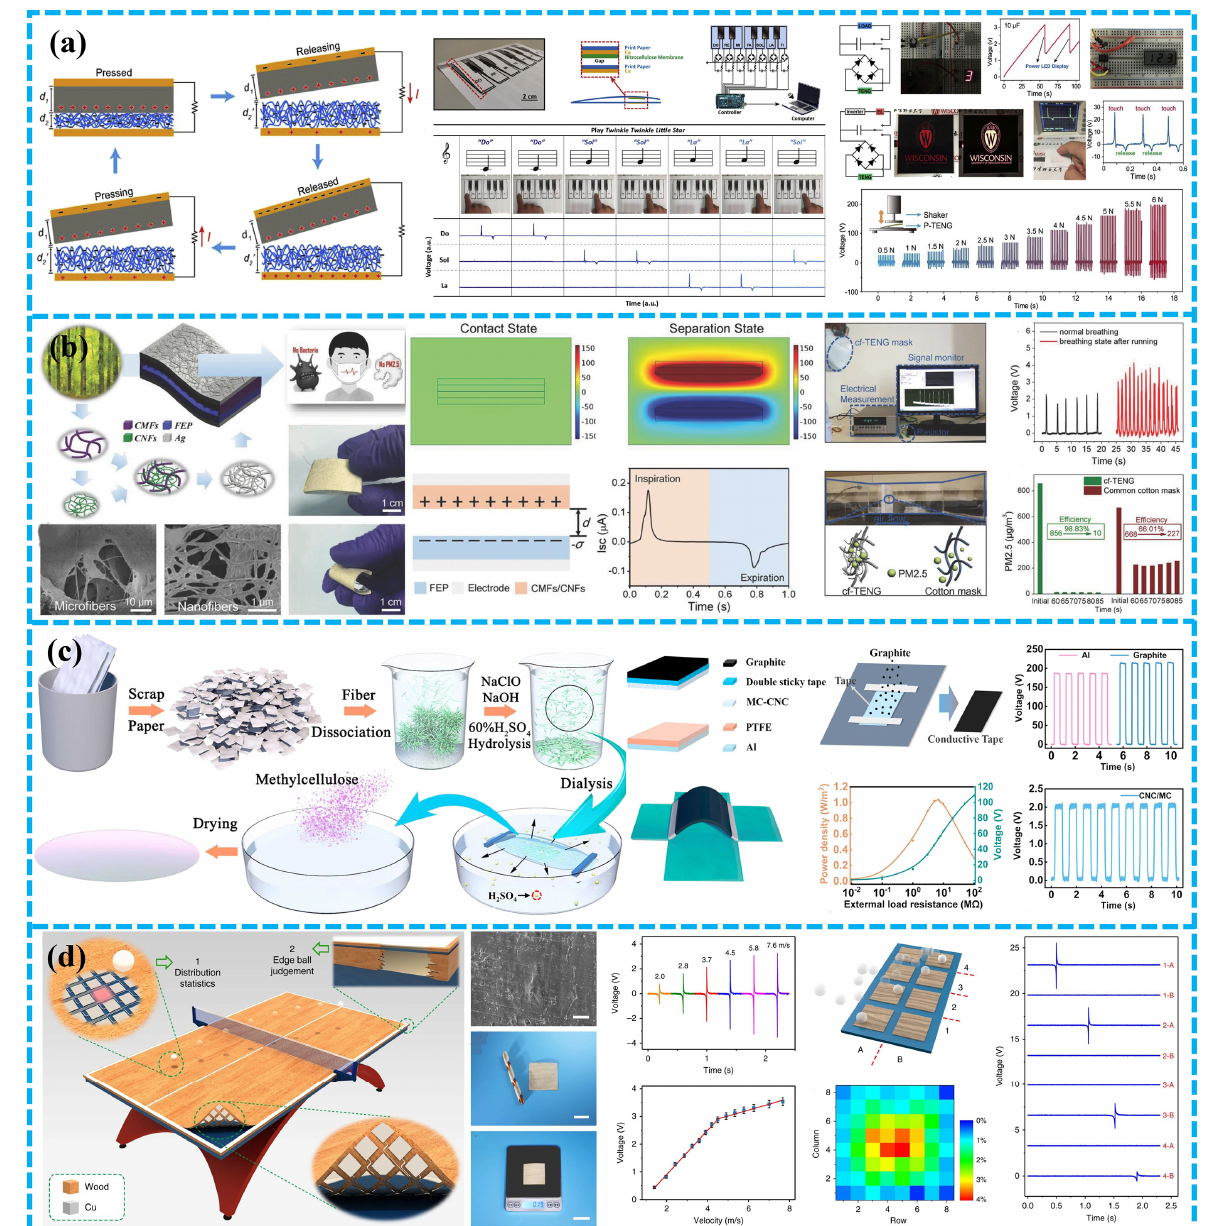
Figure 7. Plant-based BD-TENGs. ( a ) A TENG based on crepe cellulose paper and nitrocellulose film for energy harvesting and self-powered human-machine interaction; a schematic illustration of the P-TENG working principle; a P-TENG-based paper piano for self-powered human–machine interfacing; output voltage of the P-TENG under periodic pressing by a shaker with different applied forces. Reproduced with permission [68]. Copyright 2019, Elsevier Ltd. ( b ) A hierarchically nanostructured cellulose fiber-based TENG for self-powered healthcare products; schematic, microstructure, and photographs of the cf-TENG; working principle of the cf-TENG and Breathing monitoring and PM2.5 removal effect of the cf-TENG. Reproduced with permission [88], WILEY-VCH. ( c ) A recyclable and fully biodegradable water-soluble paper-based TENG; fabrication of CNC from wasted paper and schematic illustration of contact-separation mode TENG between CNC/MC film adhered with graphite electrode and PTFE. Reproduced with permission [69], Copyright 2021, Elsevier Ltd. ( d ) A flexible and durable wood TENG for self-powered sensing in sports big data analysis; fabrication and schematic of the flexible wood-based TENG and smart ping-pong table and application of the W-TENG in a self-powered falling point distribution statistical system. Reproduced with permission [89], Copyright 2019, Springer Nature.